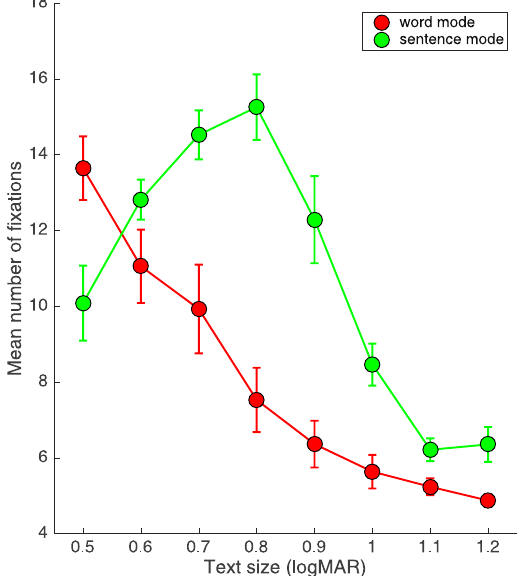
Figure 4. Average number of fixations per sentence, averaged across all four observers, as a function of text size (logMAR) for both Word Mode (red circles) and Sentence Mode (green circles). Error bars ( ± 84% CI) represent inter-observer variability.